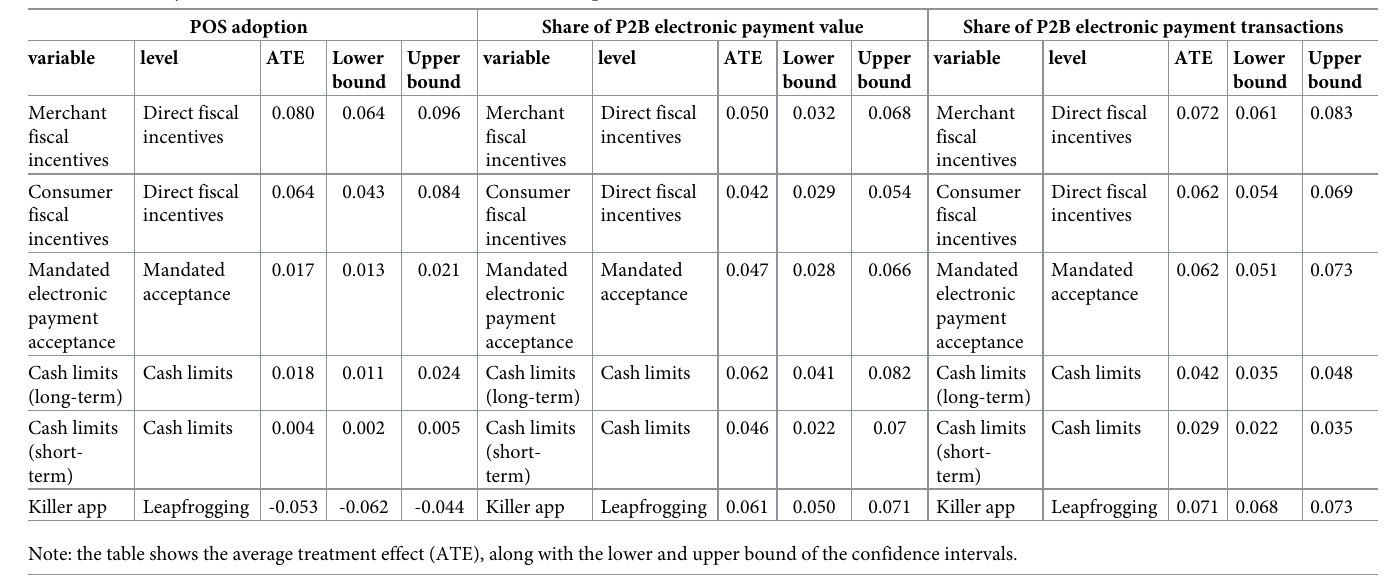
Table 5. Summary of treatment effects from the merchant-level